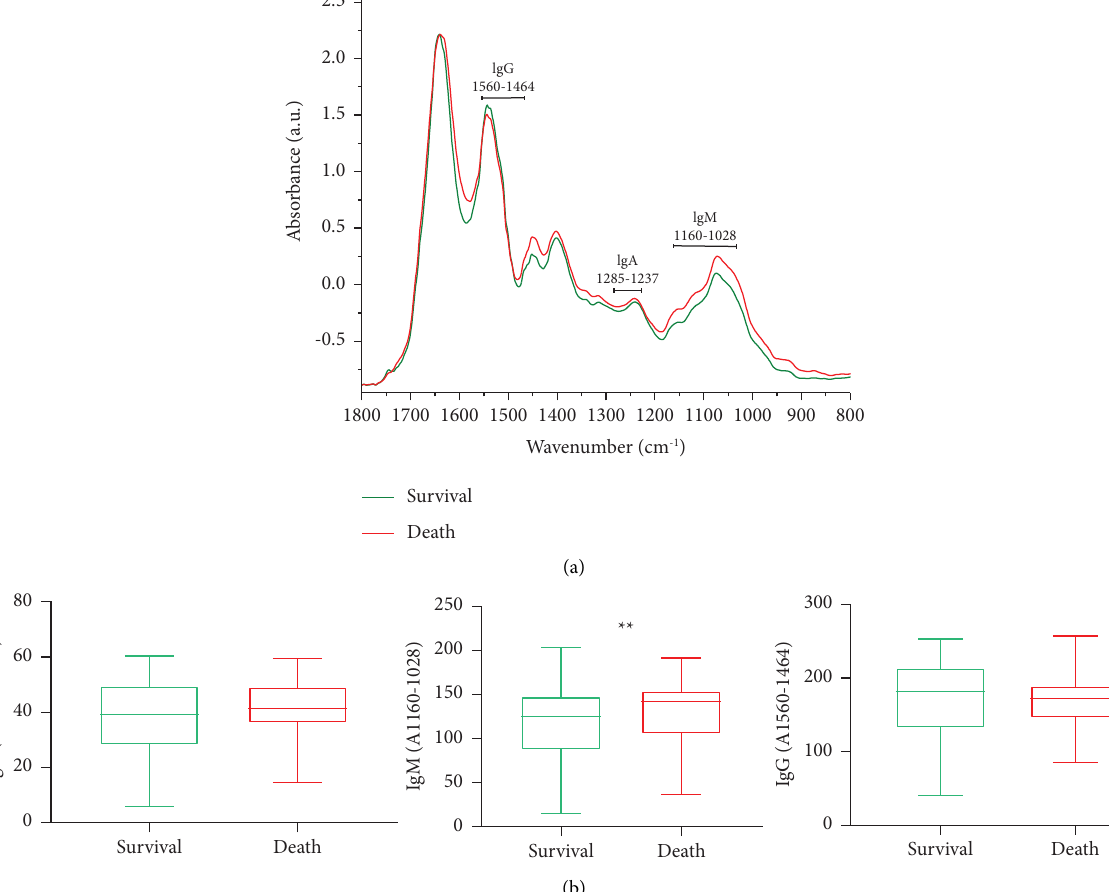
Figure 4: Immunoglobulins content on hospitalized patients with severe COVID-19 who survived or died. (a) ATR-FTIR spectra of the immunoglobulin’s regions in the fngerprint region. (b) IgA, IgM, and IgG (median and RIQ) levels. Mann–Whitney U test. ∗∗ p < 0 . 005.